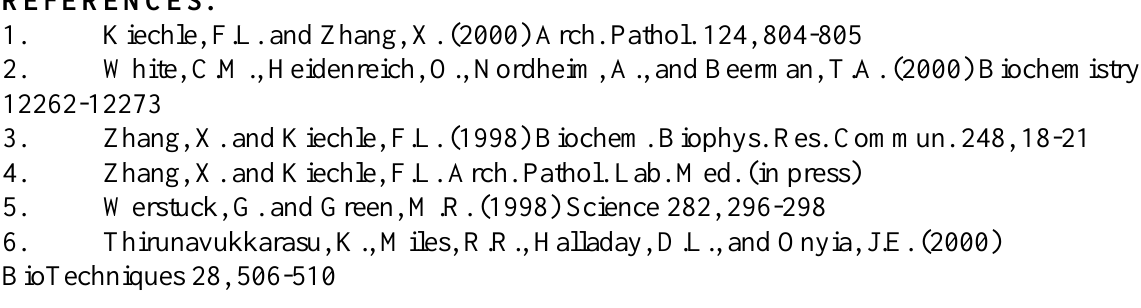
DISCUSSION. H342 inhibits the formation of TBP/DNA complexes (1,3), β